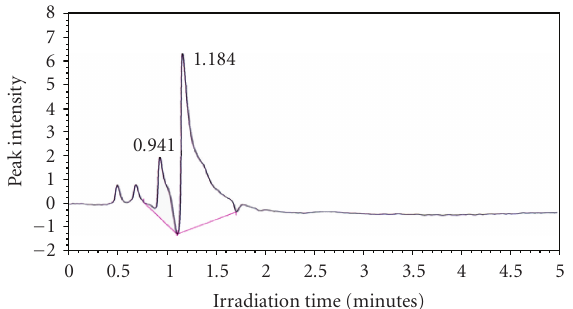
Figure 3: HPLC analysis of glyphosate in aqueous suspension of TiO 2 in the dark (zero irradiation time).